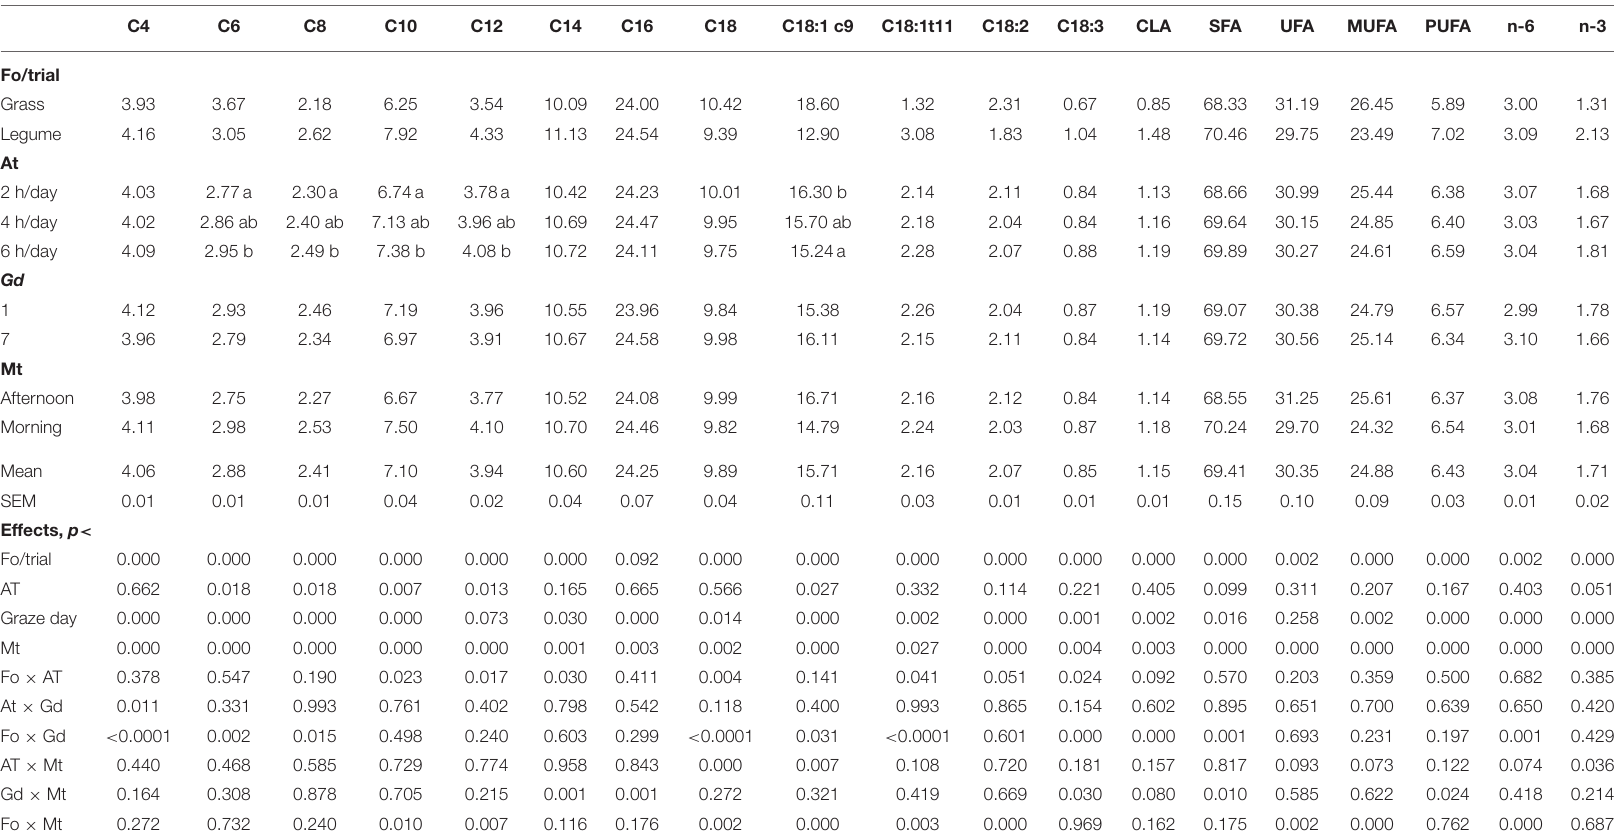
TABLE 3 | Fatty acid (FA) profile (means expressed as g/100g fatty acid methyl ester (FAME), mean and standard error of the mean (SEM) of the sheep milk samples as estimated using Fourier transformed mid-infrared (FT-MIR) calibrations.